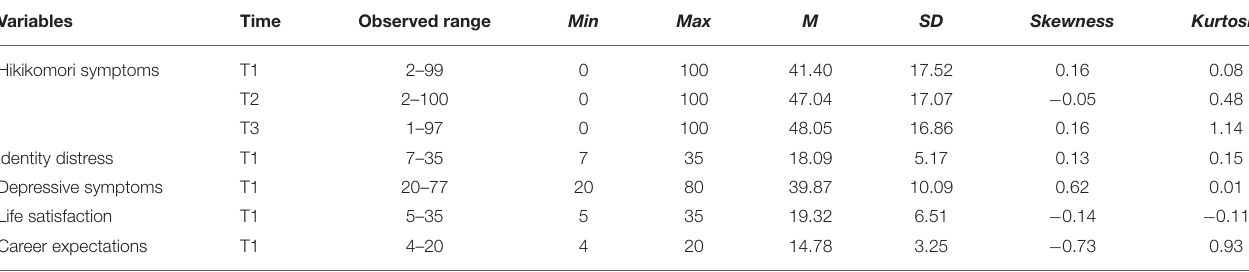
TABLE 2 | Descriptive statistics of the study variables.